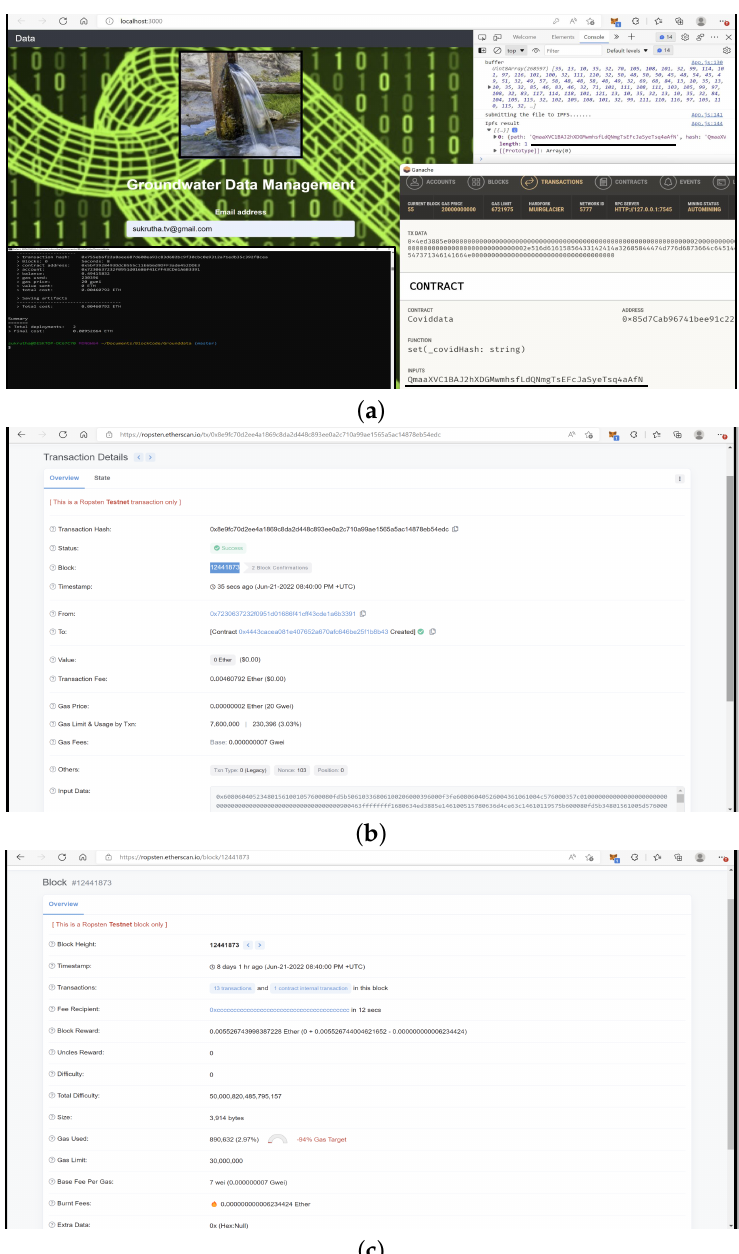
Figure 10. Dataflow from User Interface to Back-End Blockchain. ( a ) Hash verification & deploying to ropsten. ( b ) Transaction/Blockchain Hash. ( c ) Transaction Validating